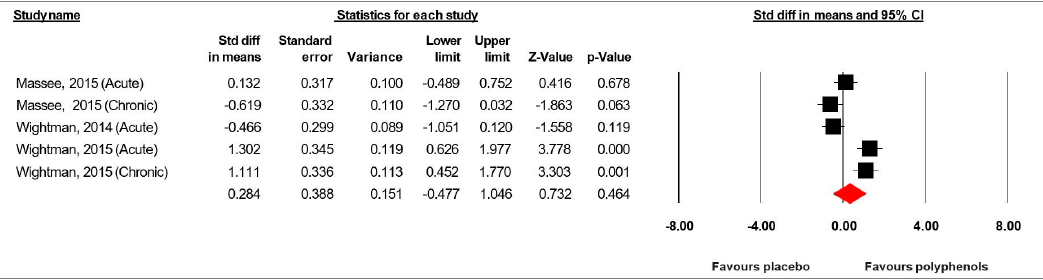
Figure 4. Forest plot of studies investigating the effect of (poly) phenols-rich supplementation on rapid visual information processing (% correct) (RVIP).